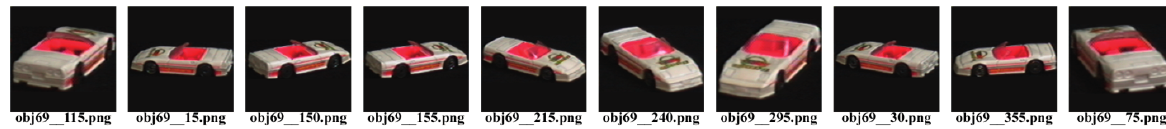
Figure 3. The 10 selected views of Class 69 of the COIL-100 database.